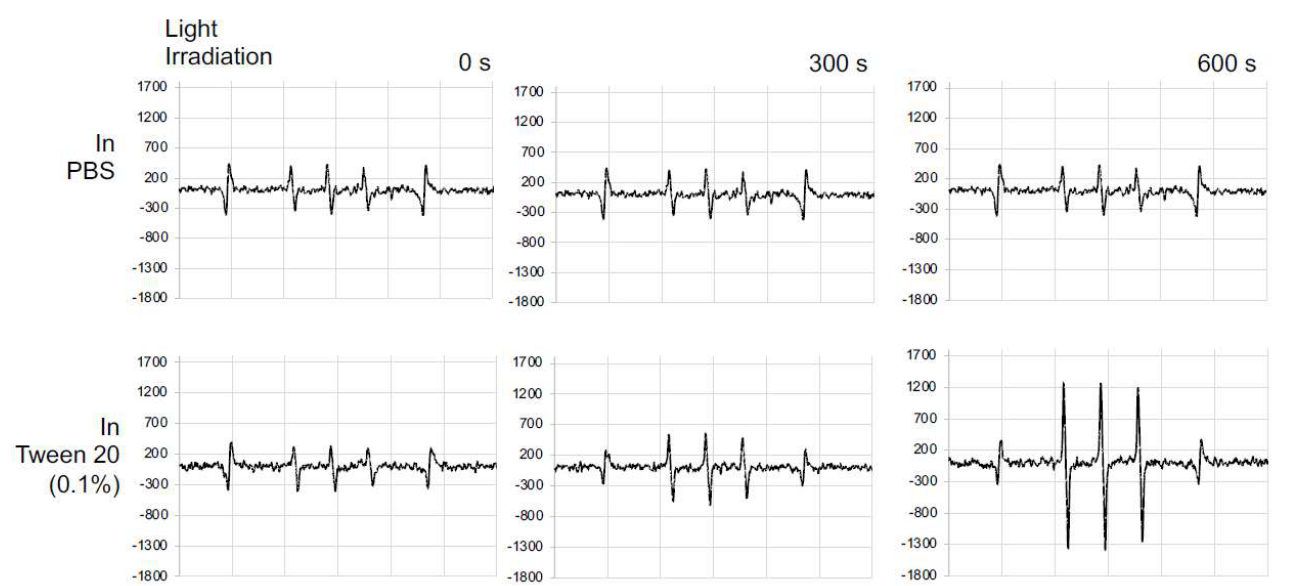
Figure 4. ESR measurement for singlet oxygen ( 1 O 2 ) generation from SMA@mTHPC. SMA@mTHPC was dissolved in PBS in the absence or presence of 0.1% Tween 20, and light irradiation (25 mW/cm 2 ) was carried out using xenon light of 400–700 nm, for the indicated times. 1 O 2 generated was captured by 4-oxo-TEMP, and triplet 4-oxo-TEMPO signal due to 1 O 2 was detected by ESR spectra. See text for details.